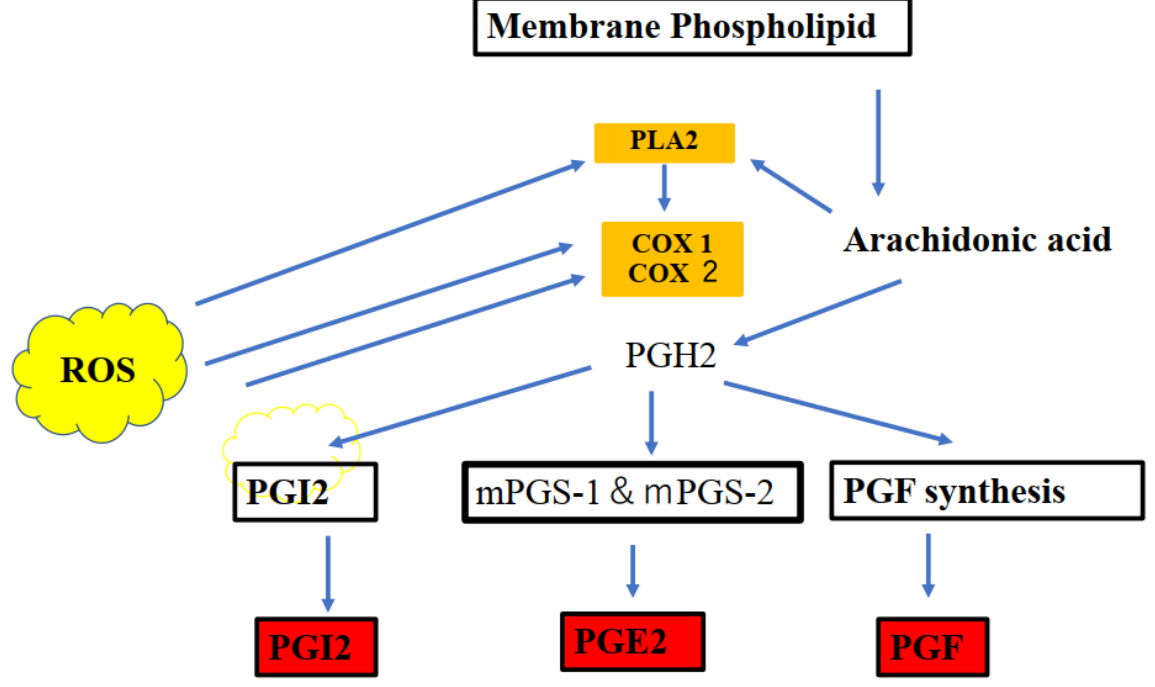
Figure 2. Cyclooxygenases 1 and 2 (COX-1 and COX-2), which are key enzymes in the conversion of arachidonic acid into bioactive prostanoids play a central role in the inflammatory cascade. Prostaglandin families (postaglandin J2) are endogenous toxic products of cyclooxygenases, and because their levels are significantly increased upon brain injury, they are actively involved in neuronal dysfunction induced by pro-inflammatory stimuli. The line of evidence indicates an important interplay between the cannabinoid receptor type 1 (CB1) and cannabinoid receptor type 2 (CB2) and endocannabinoids (ECB) are key inflammatory and redox-dependent processes. The endocannobinoid system (ECS) may also control oxidative stress by directly or indirectly modulating CB1 and CB2 signaling or CB receptor-independent processes via COX-2-dependent eicosanoid pathway. Modulation of cellular redox homeostasis is induced by the ECS. The reactive oxygen species (ROS) act as second messengers and exert oxidative activity to influence immune, inflammatory, and other signaling